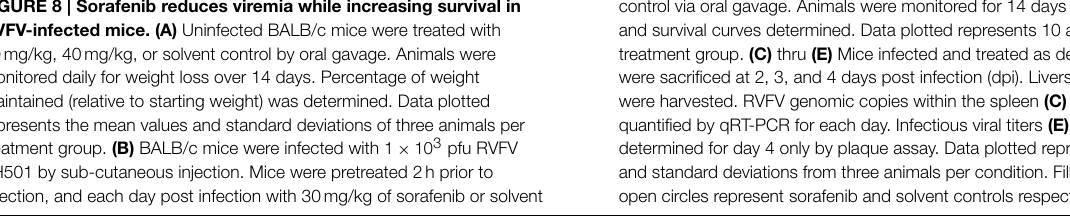
FIGURE 8 | Sorafenib reduces viremia while increasing survival in RVFV-infected mice. (A) Uninfected BALB/c mice were treated with 20mg/kg, 40mg/kg, or solvent control by oral gavage. Animals were monitored daily for weight loss over 14 days. Percentage of weight maintained (relative to starting weight) was determined. Data plotted represents the mean values and standard deviations of three animals per treatment group. (B) BALB/c mice were infected with 1 × 10 3 pfu RVFV ZH501 by sub-cutaneous injection. Mice were pretreated 2h prior to infection, and each day post infection with 30mg/kg of sorafenib or solvent